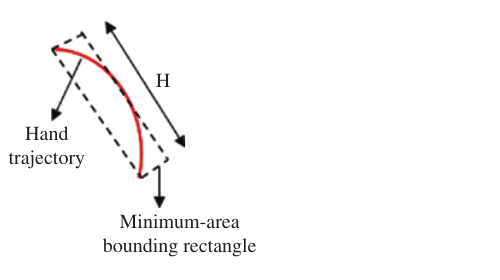
Figure 5: Extraction of the Height of Hand Trajectory for Modeling the ME